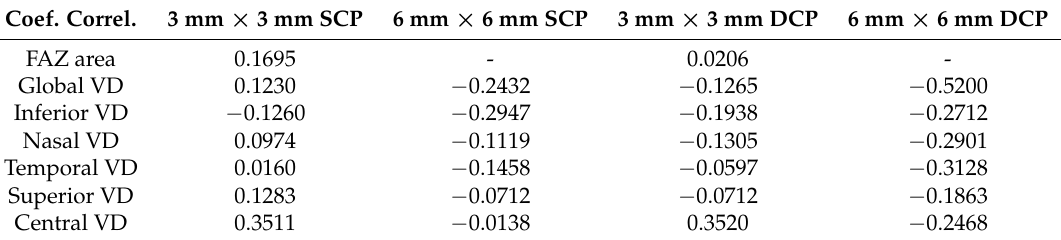
Table 1. Coefficient of correlation of each variable with the